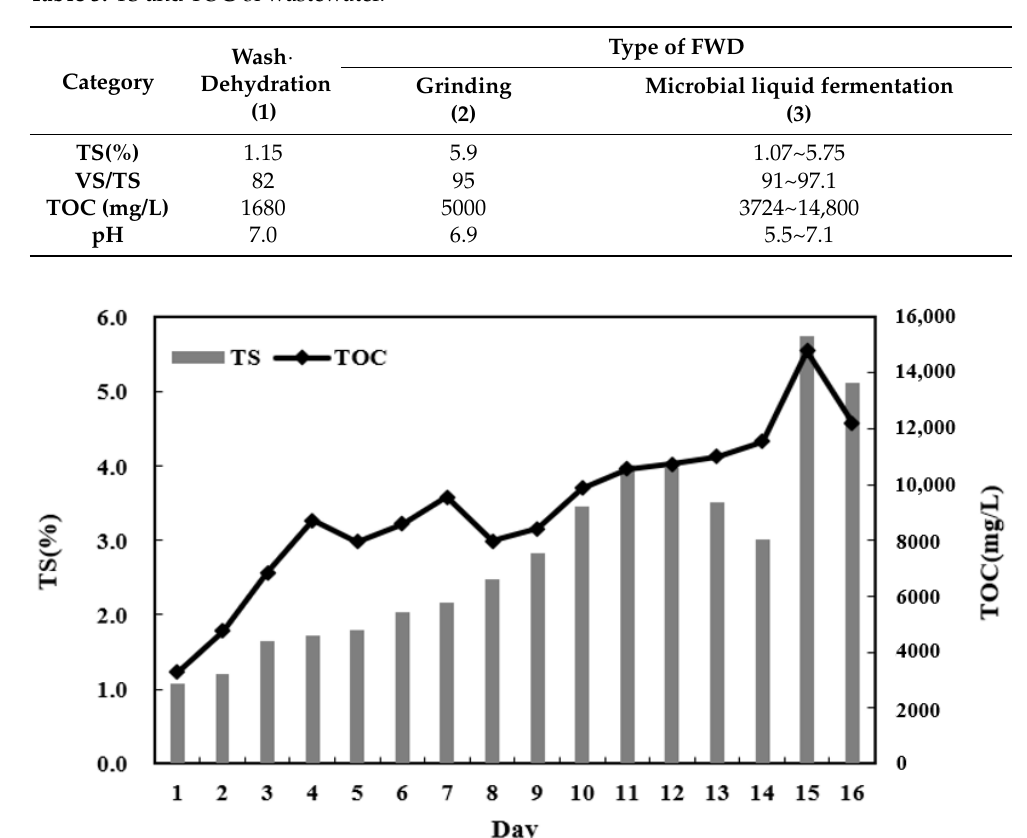
Table 3. TS and TOC of wastewater.